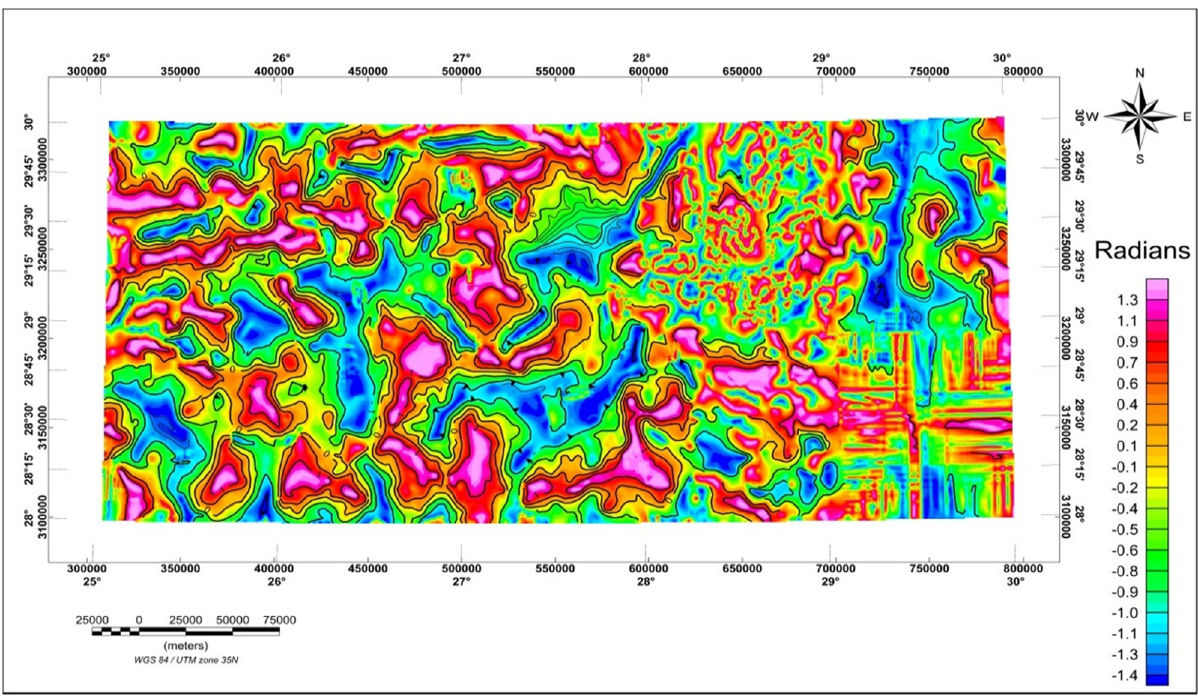
Figure 12: Tilt derivative of the RTP magnetic